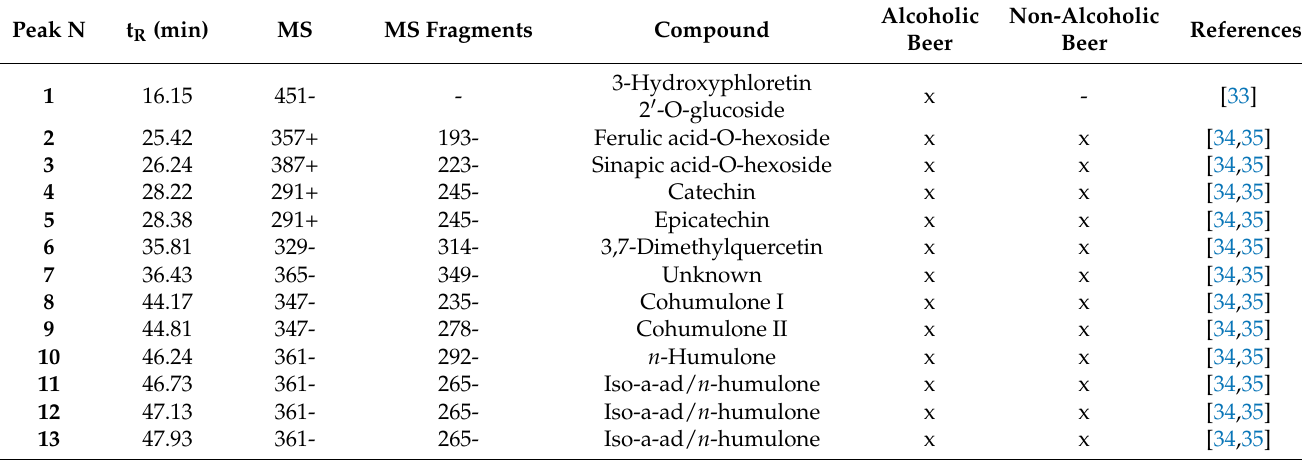
Table 2. Characterization of phenolic compounds in alcoholic and non-alcoholic beer samples by HPLC – MS .